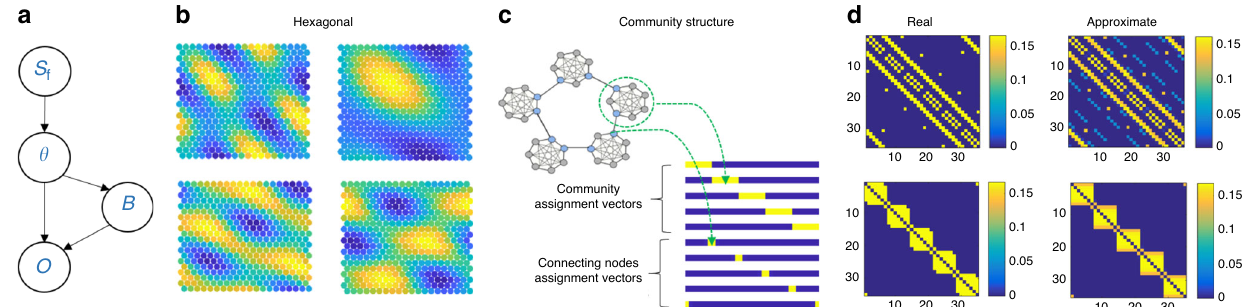
Fig. 3 Inferring graph structure rather than learning it using a basis sets representation for structural knowledge. a We present a generative model for graphs. Each graph belongs to a structural form ( S f ). Given a structural form, graph size ( θ ) is sampled from prior distribution ( p ( θ | S f )) and the transition matrix is approximated. Given a transition matrix ( A θ sf , that is determined by the form and the dimensions) an emission matrix (B) is sampled. From these two matrices, the sequence of observations (O) can be generated. b Basis sets for Hexagonal grid, few examples. c Basis sets for a community structure. Basis sets can allow direct inference of important graph states without the need of further computation. In a graph with underlying community structure, the connecting nodes (blue circles) are important; knowing them allows fast transitions between communities. A basis set that contains explicit connecting nodes assignment vectors allows the direct inference of their identity by learning the emission matrix. d The transition matrices can be approximated using Basis sets for structural knowledge. Upper panels: correct and approximated transition structure for Hexagonal grids with 36 nodes. Lower panels: real and approximated transition matrices for a graph with underlying community structure (35